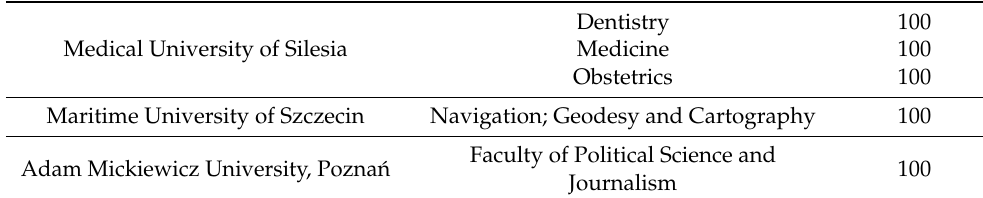
Table 1. Characteristic of students involved in the